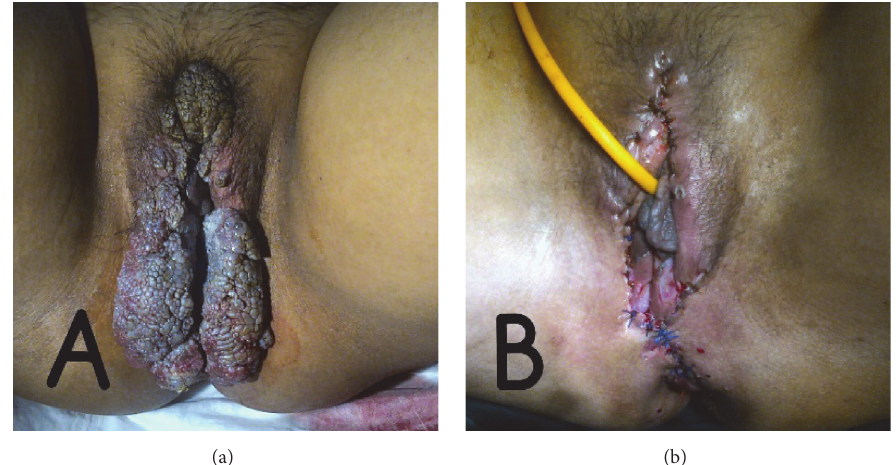
Figure 2: (a) Recurrence of condyloma acuminata in patient with systemic lupus erythematosus during methylprednisolone and mycophenolate mofetil therapy (b) after surgical procedure.